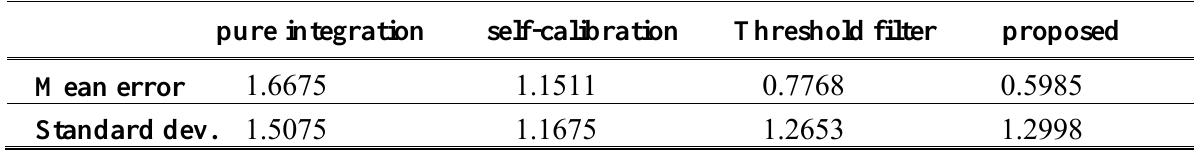
Table 1. Mean heading angle error for each method (deg)